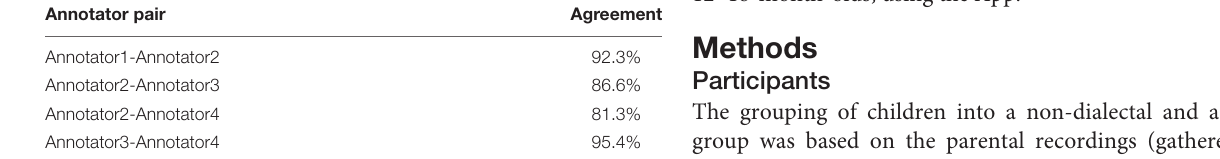
TABLE 2 | Pairwise interrater agreement for the pairs of coders for look/no-look. Annotator